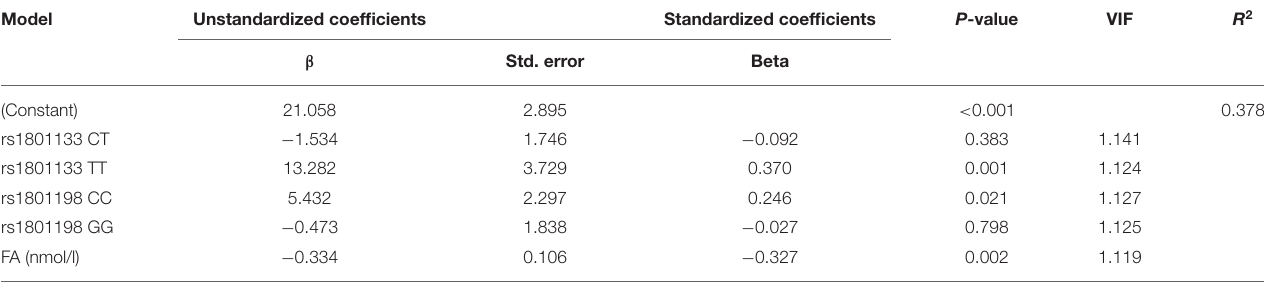
TABLE 4 | Effects of SNPs and vitamins on Hcy levels in patients with epilepsy receiving OXC monotherapy.